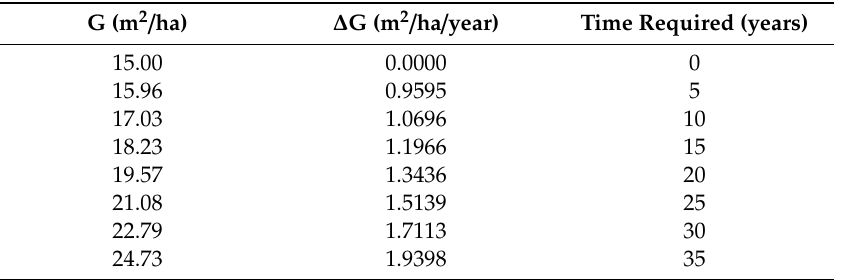
Table 3. Basal area annual increment for forest with low density.